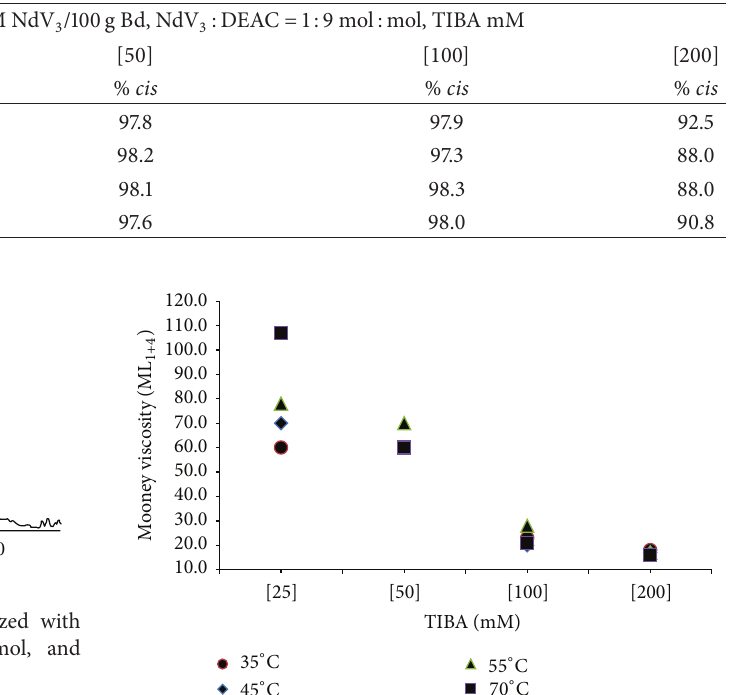
Table 2: Microstructure of high cis -1,4-BR.